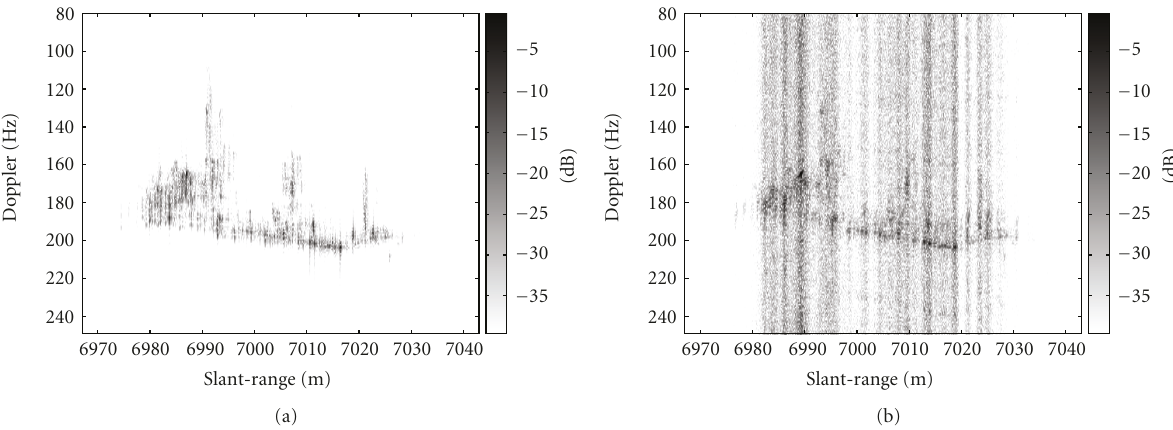
Figure 19: ISAR images obtained after applying (a) the proposed subinteger range-bin alignment method and (b) the global range alignment algorithm to the vessel data with artificially induced vibration.